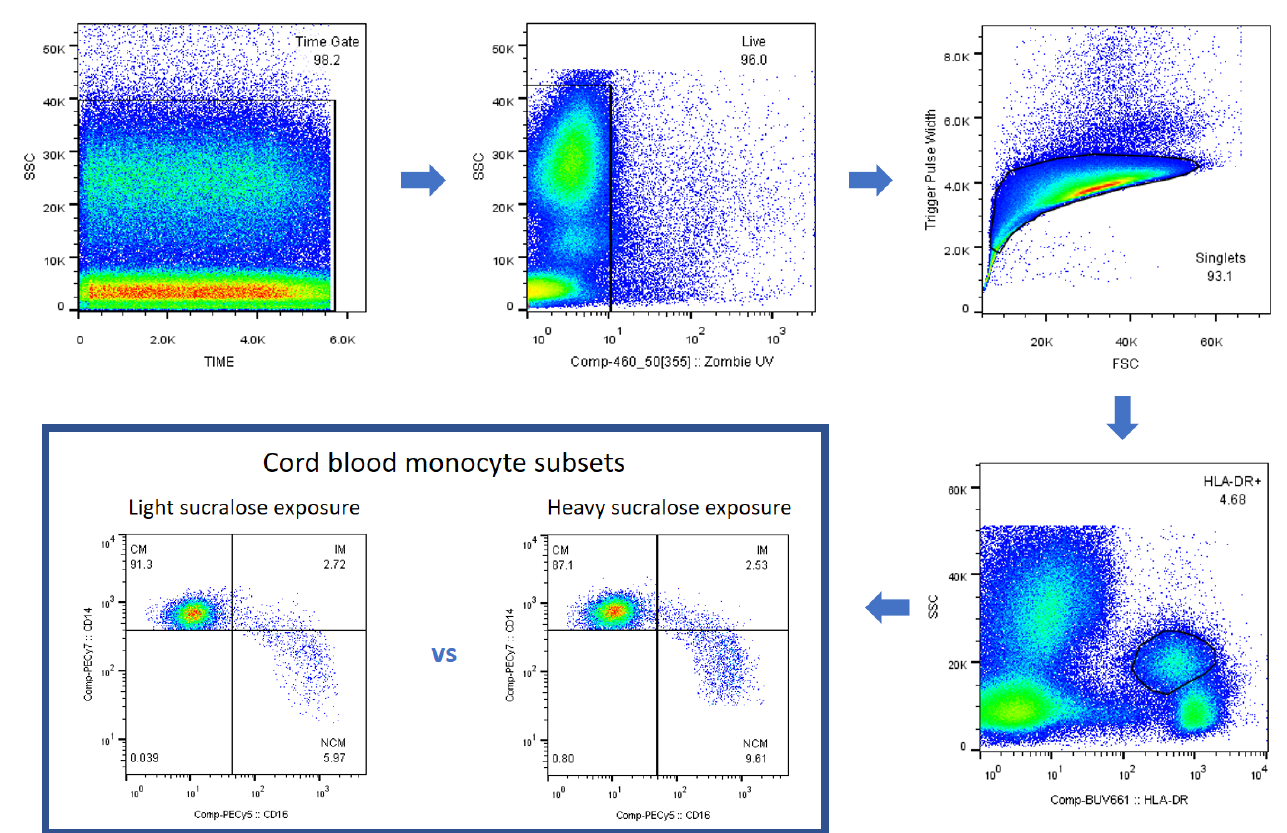
Figure 2. Gating strategy for detecting classical, intermediate, and nonclassical monocyte subsets in neonates lightly or heavily exposed to sucralose during pregnancy. CD14++CD16- cells were recognized as classical monocytes, CD14++CD16+ cells were identified as intermediate monocytes, and CD14+CD16+ cells were distinguished as nonclassical monocytes. The last panel illustrates how nonclassical monocytes significantly increase in neonates from mothers who intensely consumed sucralose during pregnancy. We acquired 1x10 4 cell events per test in triplicate corresponding to the HLA-DR+ cell population on a BD influx flow cytometer.